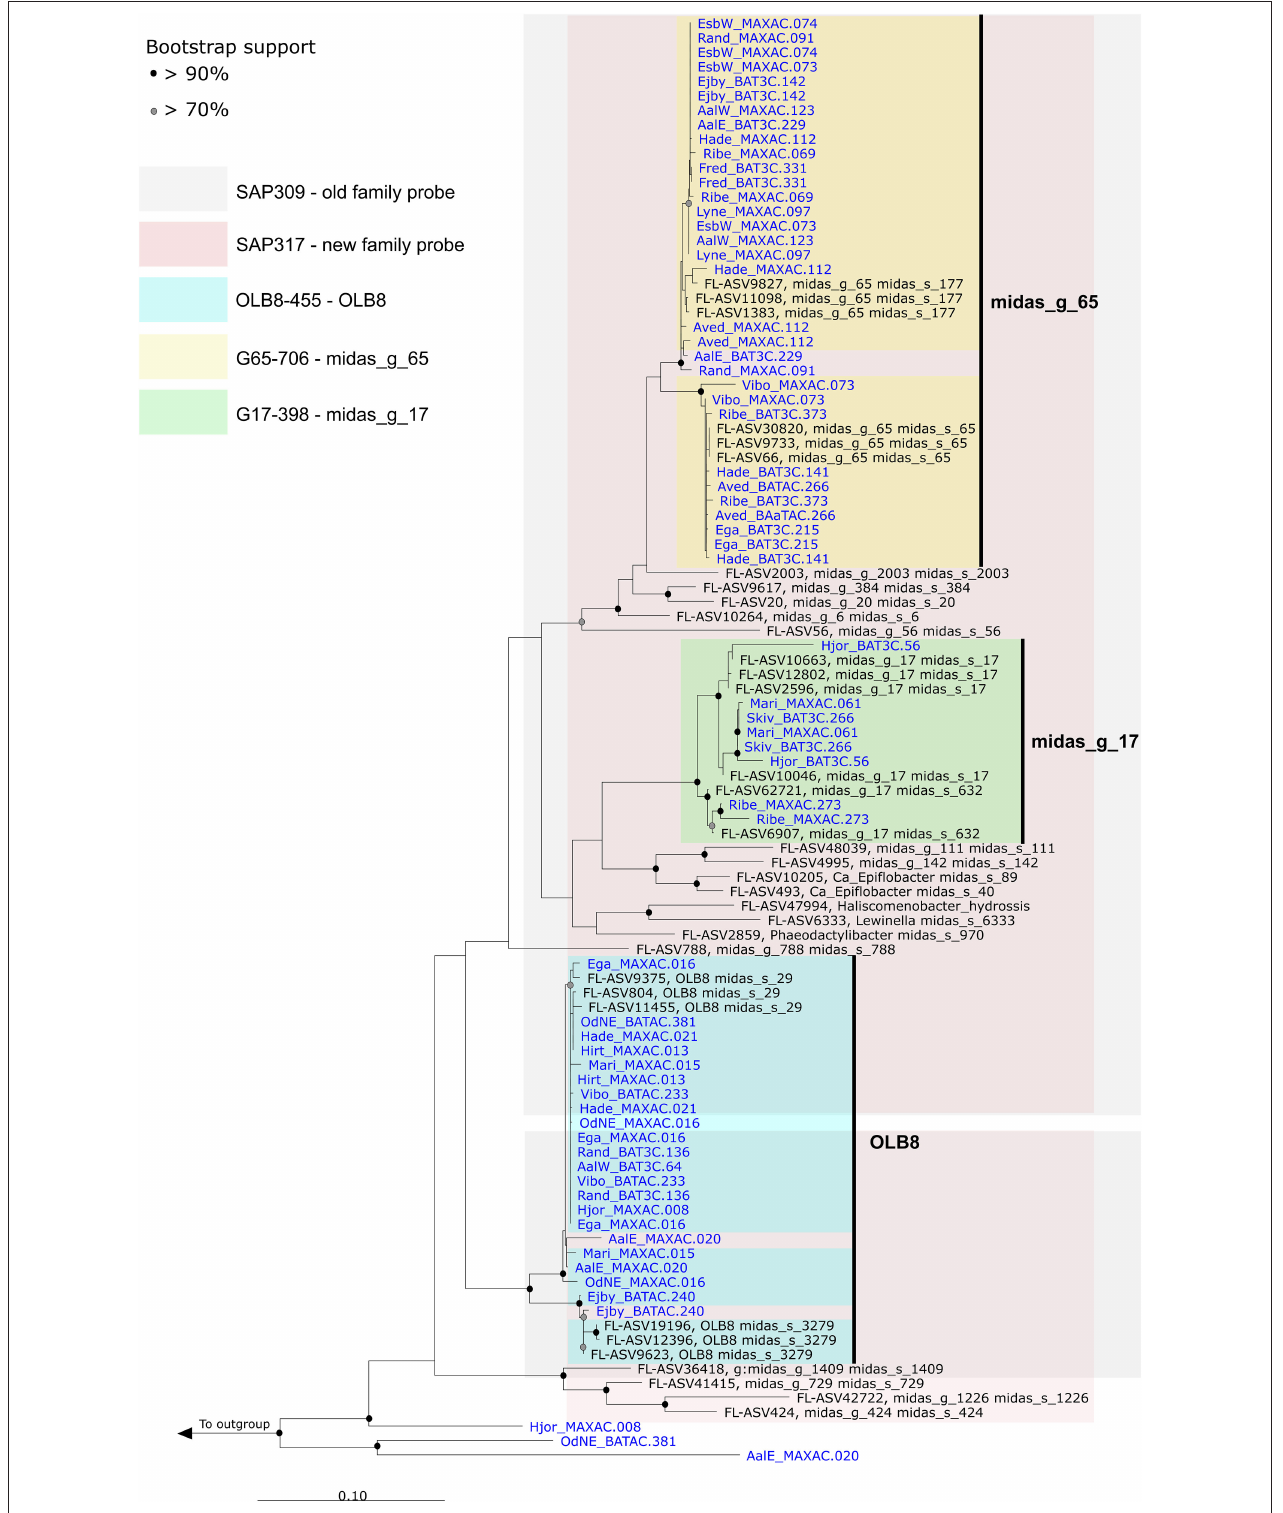
FIGURE 3 | Maximum-likelihood (PhyML) phylogenetic tree based on 16S rRNA genes of the Saprospiraceae including full-length sequences from MiDAS 4 (black) and MAG (blue). Colors indicate the coverage of FISH probes designed in this study. Bootstrap values from 1000 re-samplings are indicated for branches with > 70% (gray circles) and > 90% (black circles) support. The scale bar represents substitutions per nucleotide base.